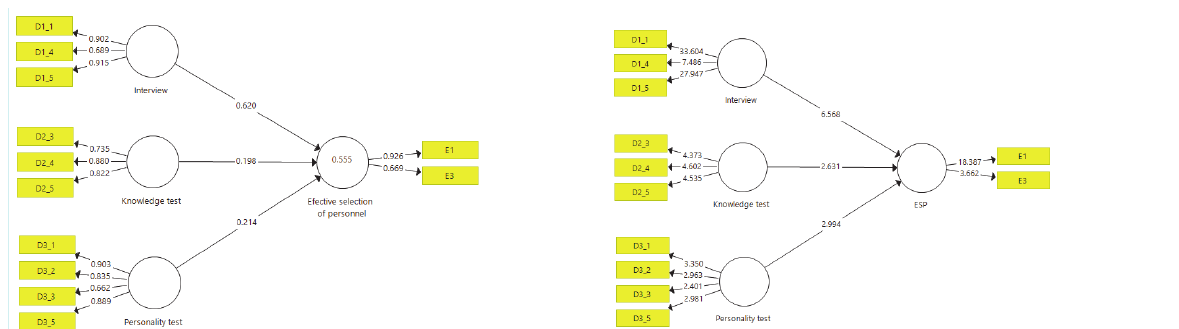
Fig. 3. Digital transformation modeling and individual work